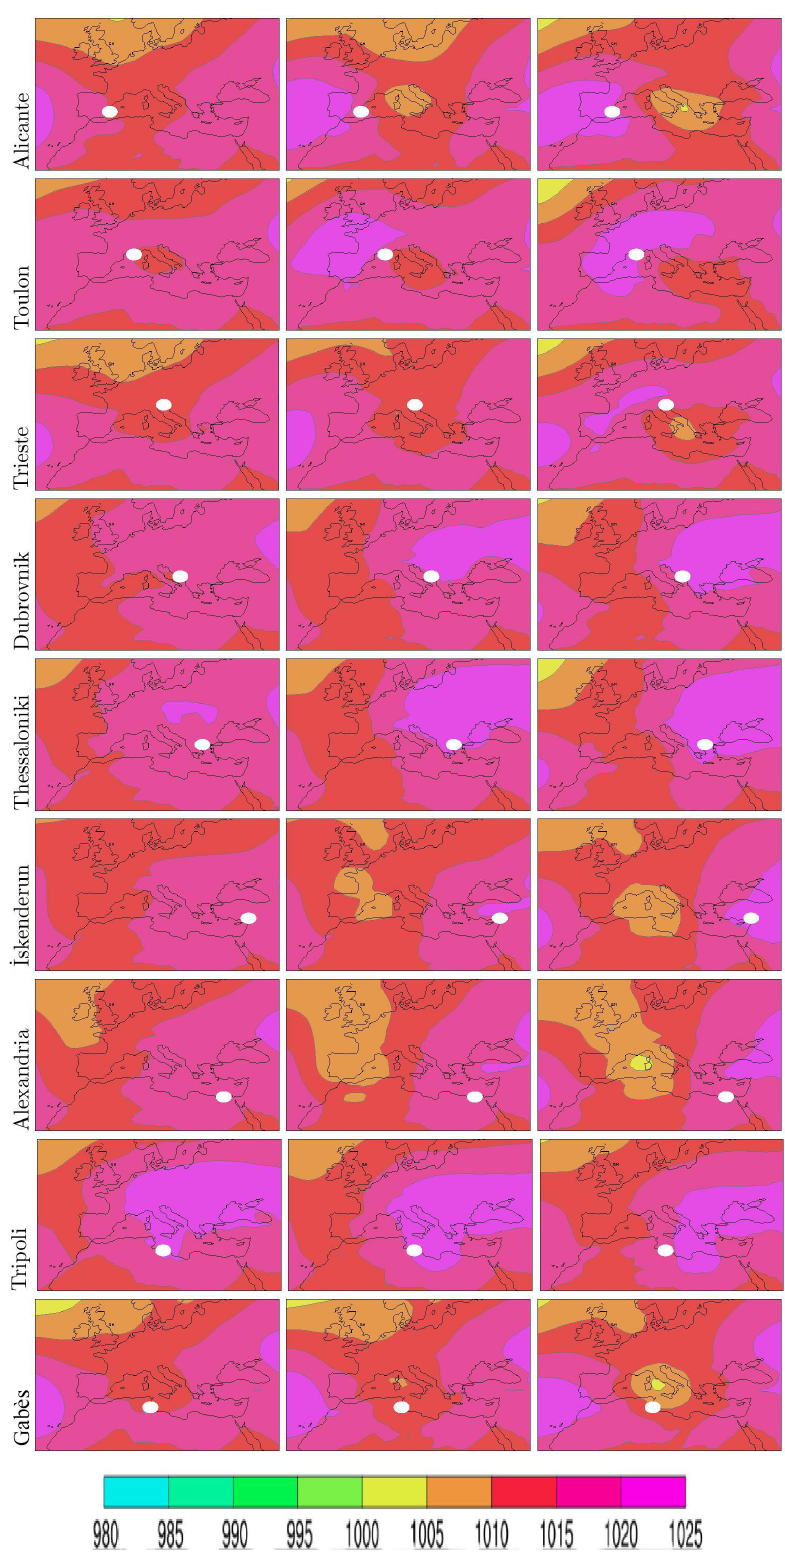
Figure 5. The same as Fig. 4 but for large negative sea level